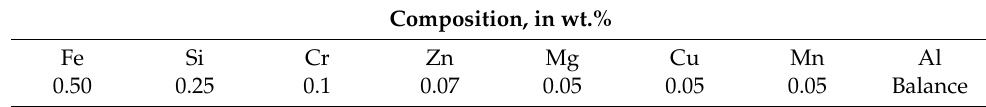
Table 1. Chemical composition of AA1050-H14 Al alloy.